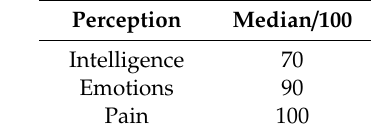
Table 2. Answers provided to “The ability of rabbits to experience emotions (e.g., sadness, joy, fear), intelligence, and pain the same way humans do”, between 0 and 100. Table 3. Answers provided to “Please choose how much you agree or disagree with the following statements: Rabbits can form strong bonds with other rabbits; Rabbits can form strong bonds with humans; Rabbits are happy to live alone” n =